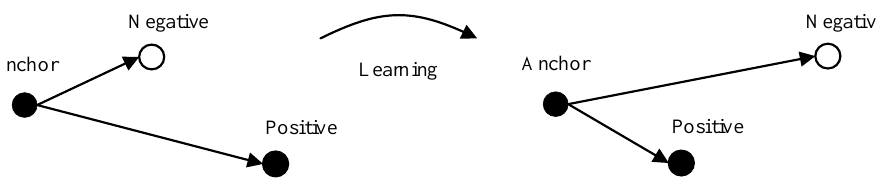
Figure 3. The learning target of the triplet network.